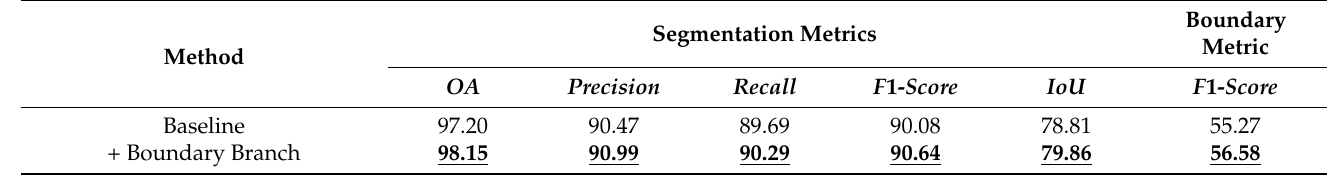
Table 5. Quantitative evaluation (%) of MBNet with and without the boundary branch. The best metric value is highlighted in bold and underlined.